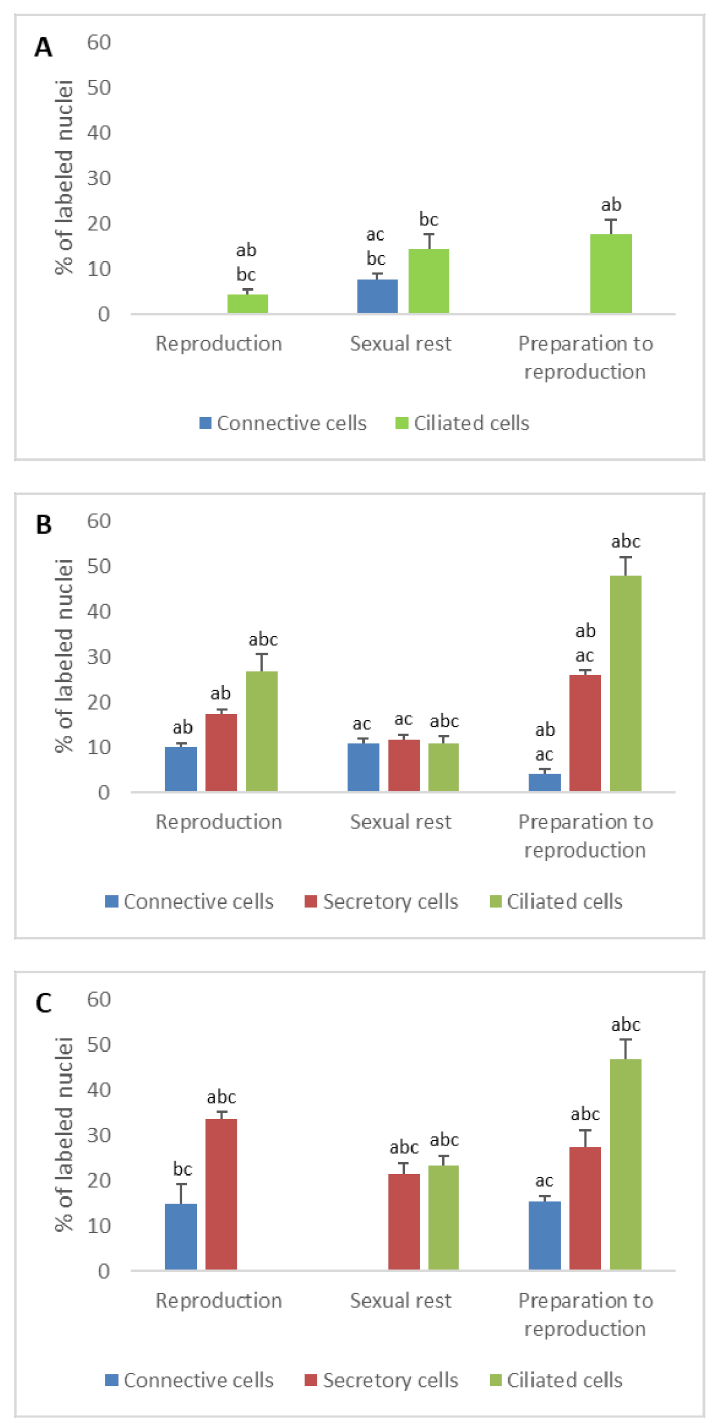
Figure 1. Percentage of PR immunodetected in the different cell types of the genital tract of Ty- phlonectes compressicauda before ovulation and during the reproduction period (pregnant females) and sexual rest (quiescent females). Significant differences (ANOVA, α = 0.05) between the 3 groups of females (a: before ovulation; b: pregnant females; c: quiescent females) are reported with the letters a, b, c. ( A ) Ostium (connective cells n = 6, Pr > F: 0.003, ciliated cells n = 6, Pr > F: 0.028); ( B ) Tubal part (connective cells n = 6, Pr > F: 0.072, secretory cells n = 6, Pr > F: 0.078, ciliated cells n = 6, Pr > F: 0.007); ( C ) Uterus (connective cells n = 6, Pr > F: 0.021, secretory cells n = 6, Pr > F: 0.042, ciliated cells n = 6, Pr >